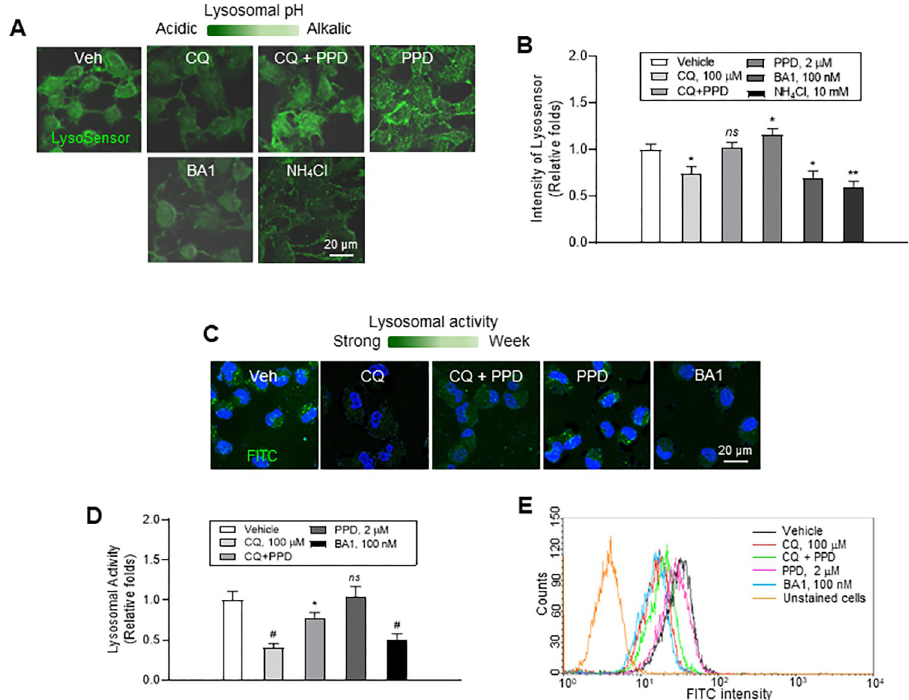
Fig 2. Protopanaxadiol (PPD) restored lysosomal pH and activity and chloroquine (CQ)-induced lysosomal alteration in adult retinal pigment epithelial (ARPE)-19 cells. (A) Colorimetric fluorescence images of ARPE-19 cells stained with pH-sensitive lysosomal dye, Lysosensor Green DND-189 where light green denotes relatively alkaline lysosomal pH. Cells were treated with vehicle, 100 μ M CQ, CQ+PPD, and 2 μ M PPD for 6 h and stained with 1 μ M Lysosensor. Bafilomycin A1 (BA1, 100 nM) and ammonium chloride (NH 4 Cl, 10 mM) were used as anti-lysosomal experimental controls. (B) Bars denote relative changes in green fluorescence intensity analyzed using “Mean region of interest [ROI]” option in Zen software (n = 3–9). (C) Florescence microscopy images of ARPE-19 cells showing lysosomal intracellular activity. Cells were treated as in (A) with self-quenched substrate. Veh: untreated positive control, BA1: negative control cells. Dark green indicates stronger lysosomal intracellular activity than that shown by light green. (D) Bars show relative changes in green fluorescence intensity analyzed using “Mean ROI” option in Zen software (n = 3–9). (E) Fluorescence-activated cell sorting (FACS) acquisition and analysis of ARPE-19 cells showing lysosomal intracellular activity. Comparison of histograms of flow cytometric analysis (fluorescent channel 1/ fluorescein isothiocyanate [FL1/FITC] channel), showing the inhibition of substrate de-quenching following treatment with lysosome-depolarizing agent: unstained (light brown curve), untreated positive control (black curve), CQ (red curve), CQ+PPD (green curve), PPD (crimson curve), and experimental control cells treated with 1 × BA1 (blue curve). Scale bar, 20 μ m. Mean ± standard deviation (SD), ns ; not significant, n = 3; � P < 0.05 and # P < 0.001 compared to vehicle